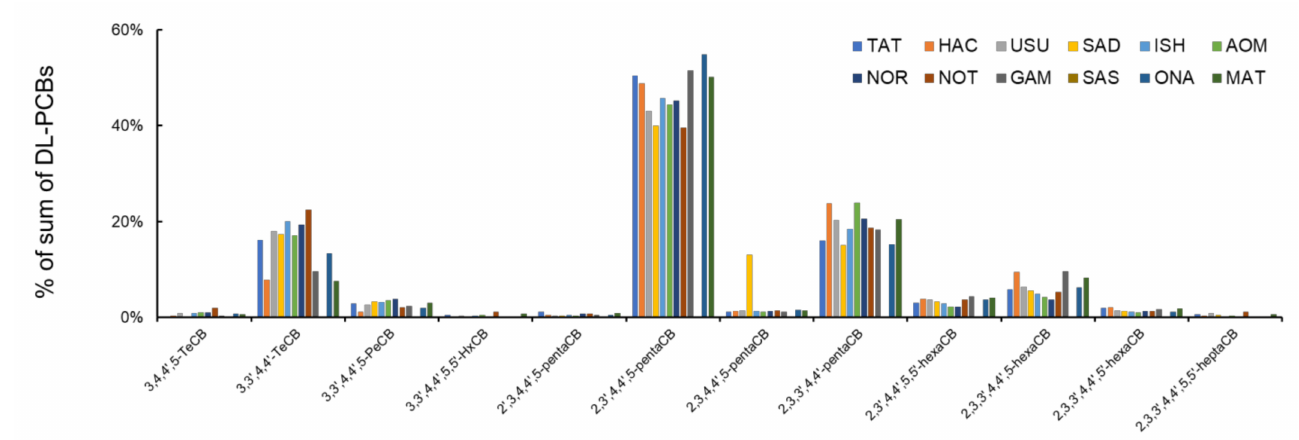
Figure 4. Percentage of individual DL-PCBs in the sum of DL-PCBs at 11 sampling